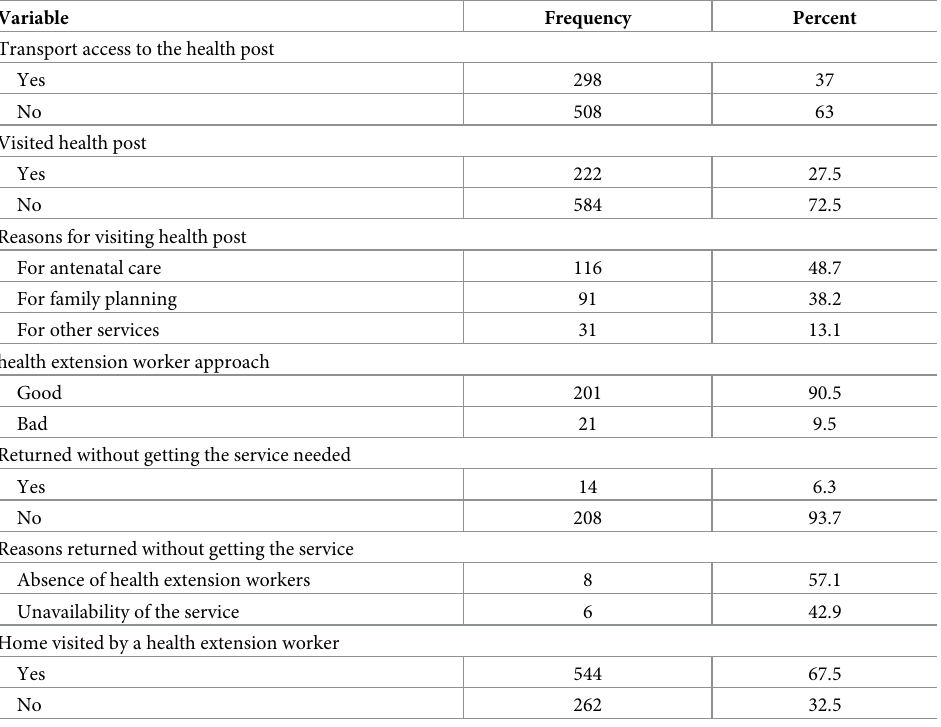
Table 2. Service related issues among respondents (n = 806) in East Gojjam Zone, Northwest Ethiopia, 2019.